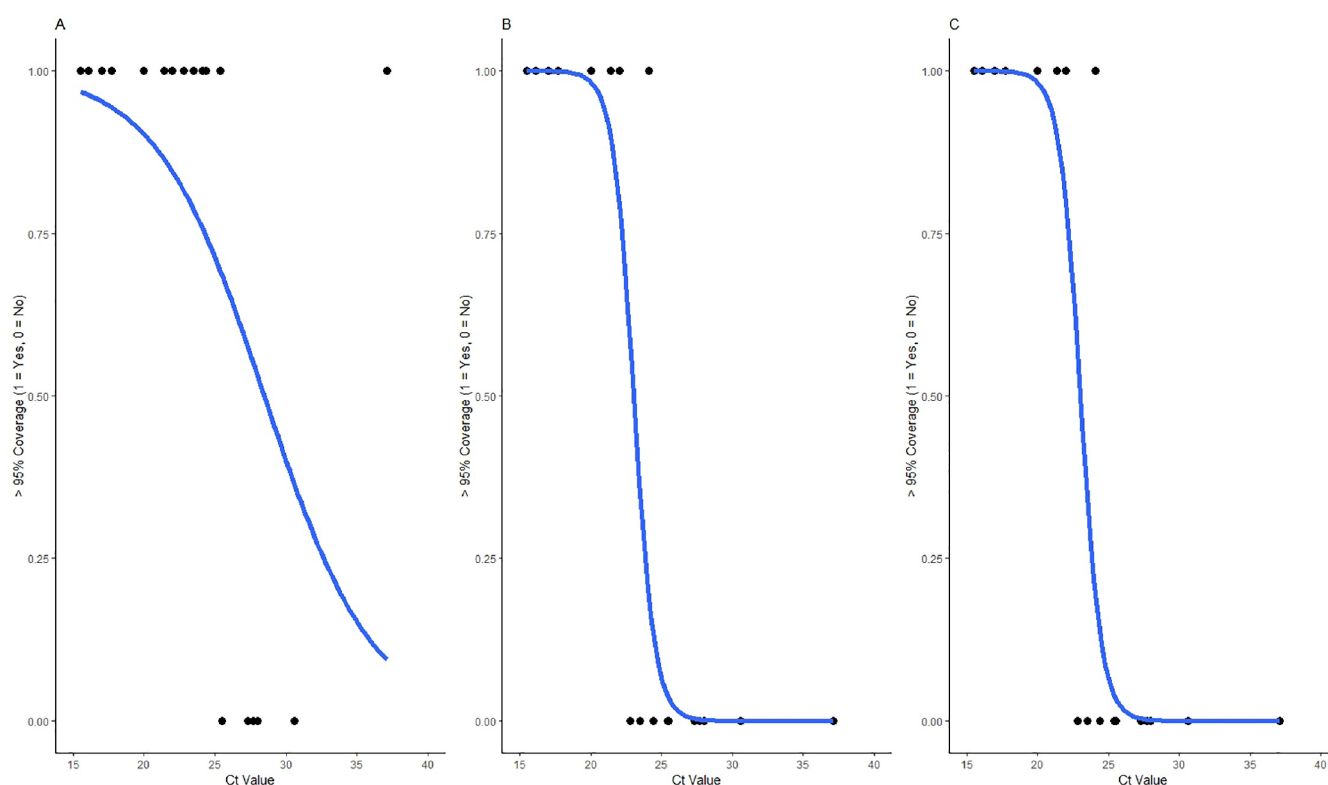
Fig 3. Probability of obtaining greater than 95% genome coverage (1 = Yes, 0 = No) for RT-qPCR positive study samples across C t value for a. 1x, b. 20x, and c. 50x genome coverage. Logistic regression models are represented in blue.